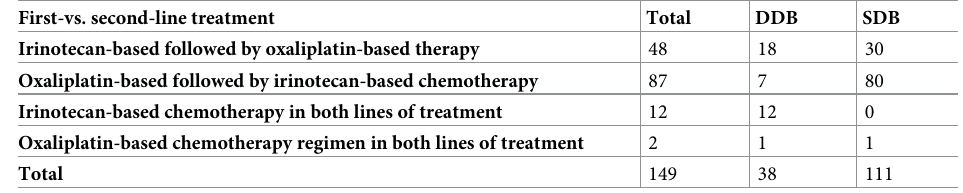
Table 4. Summary of treatment changes at first